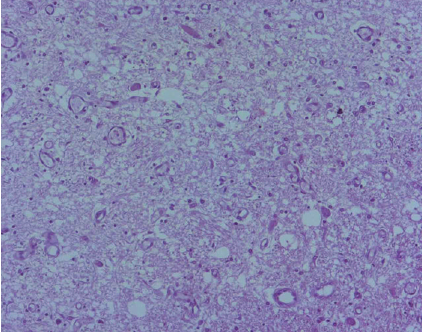
Figure 1: Reddish, sunken foci within the pons.